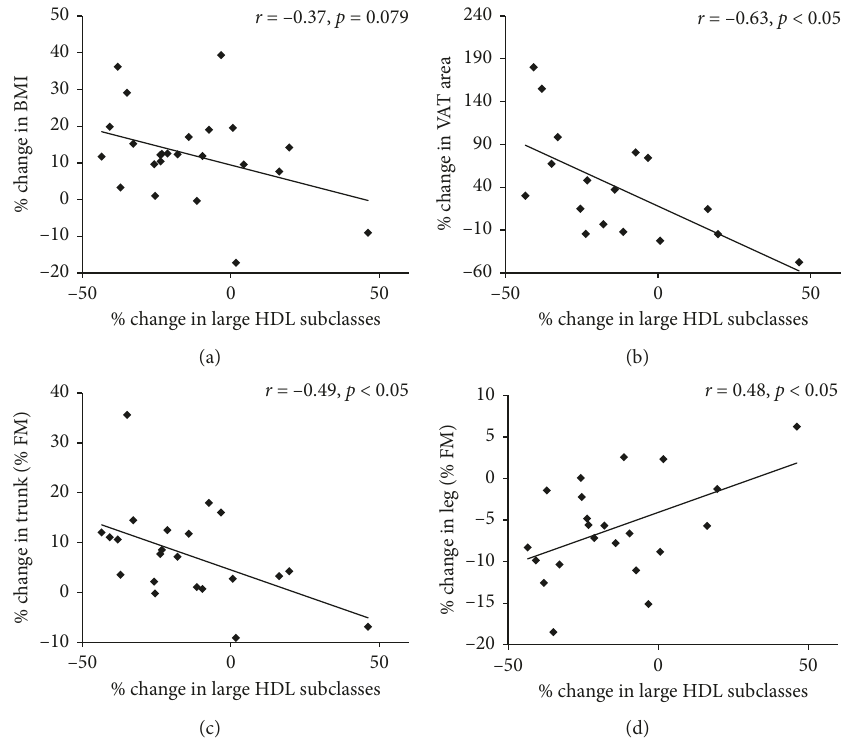
Figure 1: Associations between percentage changes in large HDL subclasses and body fat distribution. Percentage changes in BMI (a), VAT area (b), percentage trunk fat mass (c), and leg fat mass (d) were plotted against percentage changes in large HDL subclasses. Results represent Pearson correlation